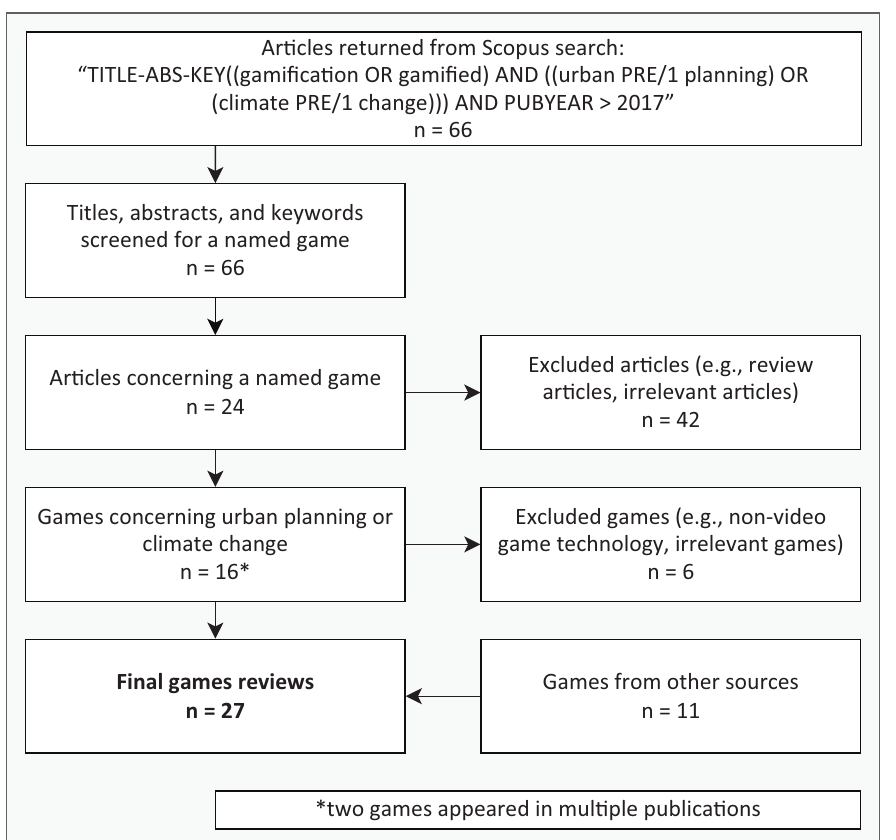
Figure 1. Systematic approach to filtering articles for